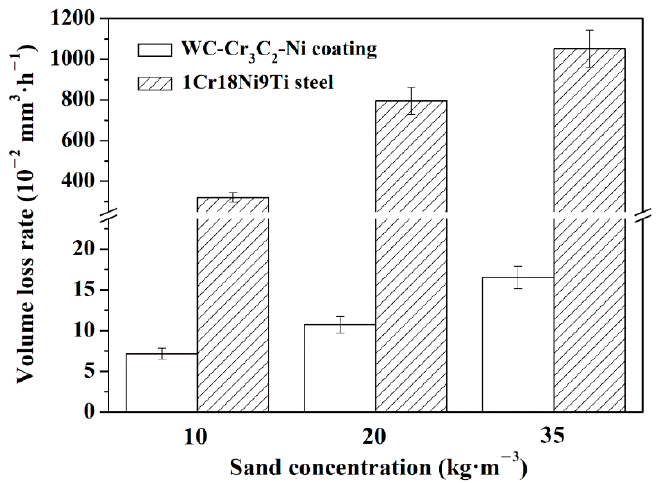
Figure 8. Volume loss rates of the WC-Cr 3 C 2 -Ni coating and the 1Cr18Ni9Ti stainless steel after CSE for 6 h in 3.5 wt.% SCM at 33.5 m · s − 1 and different SCs.